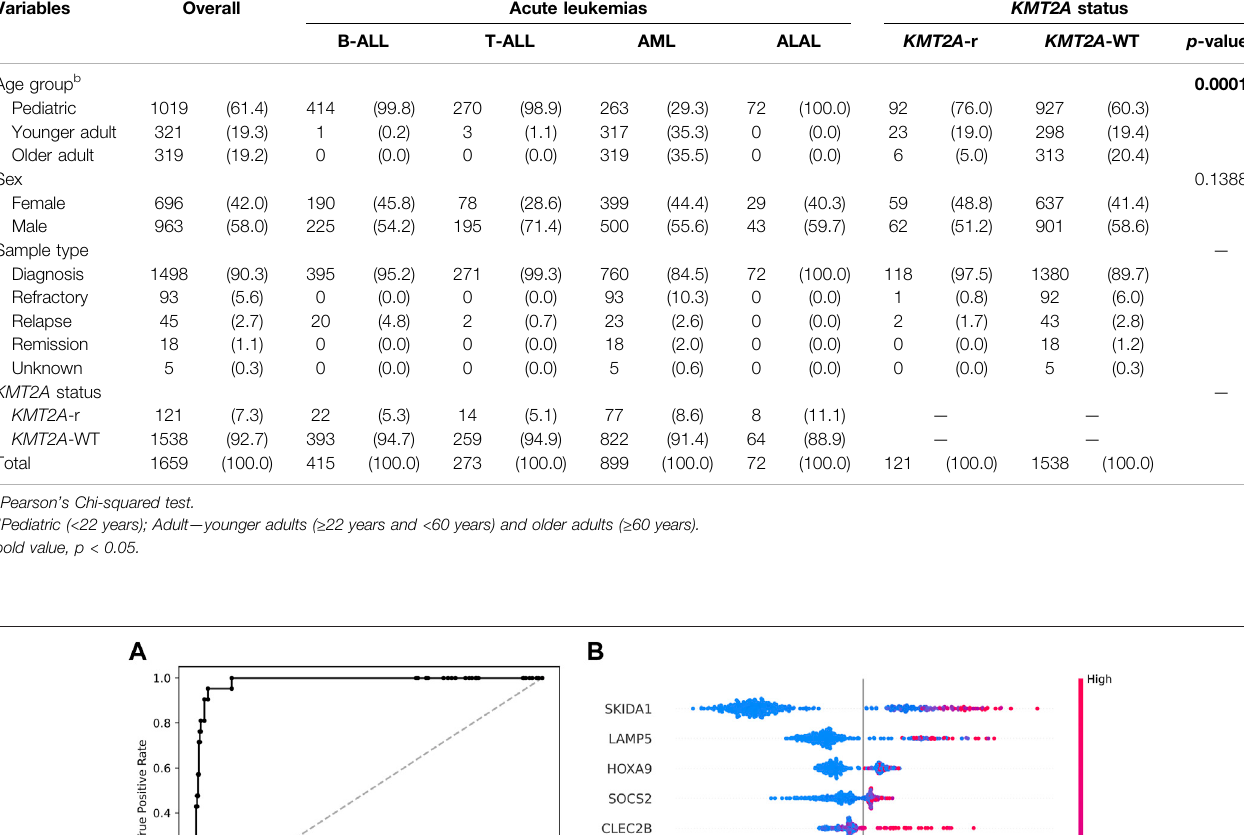
Frontiers in Pharmacology |